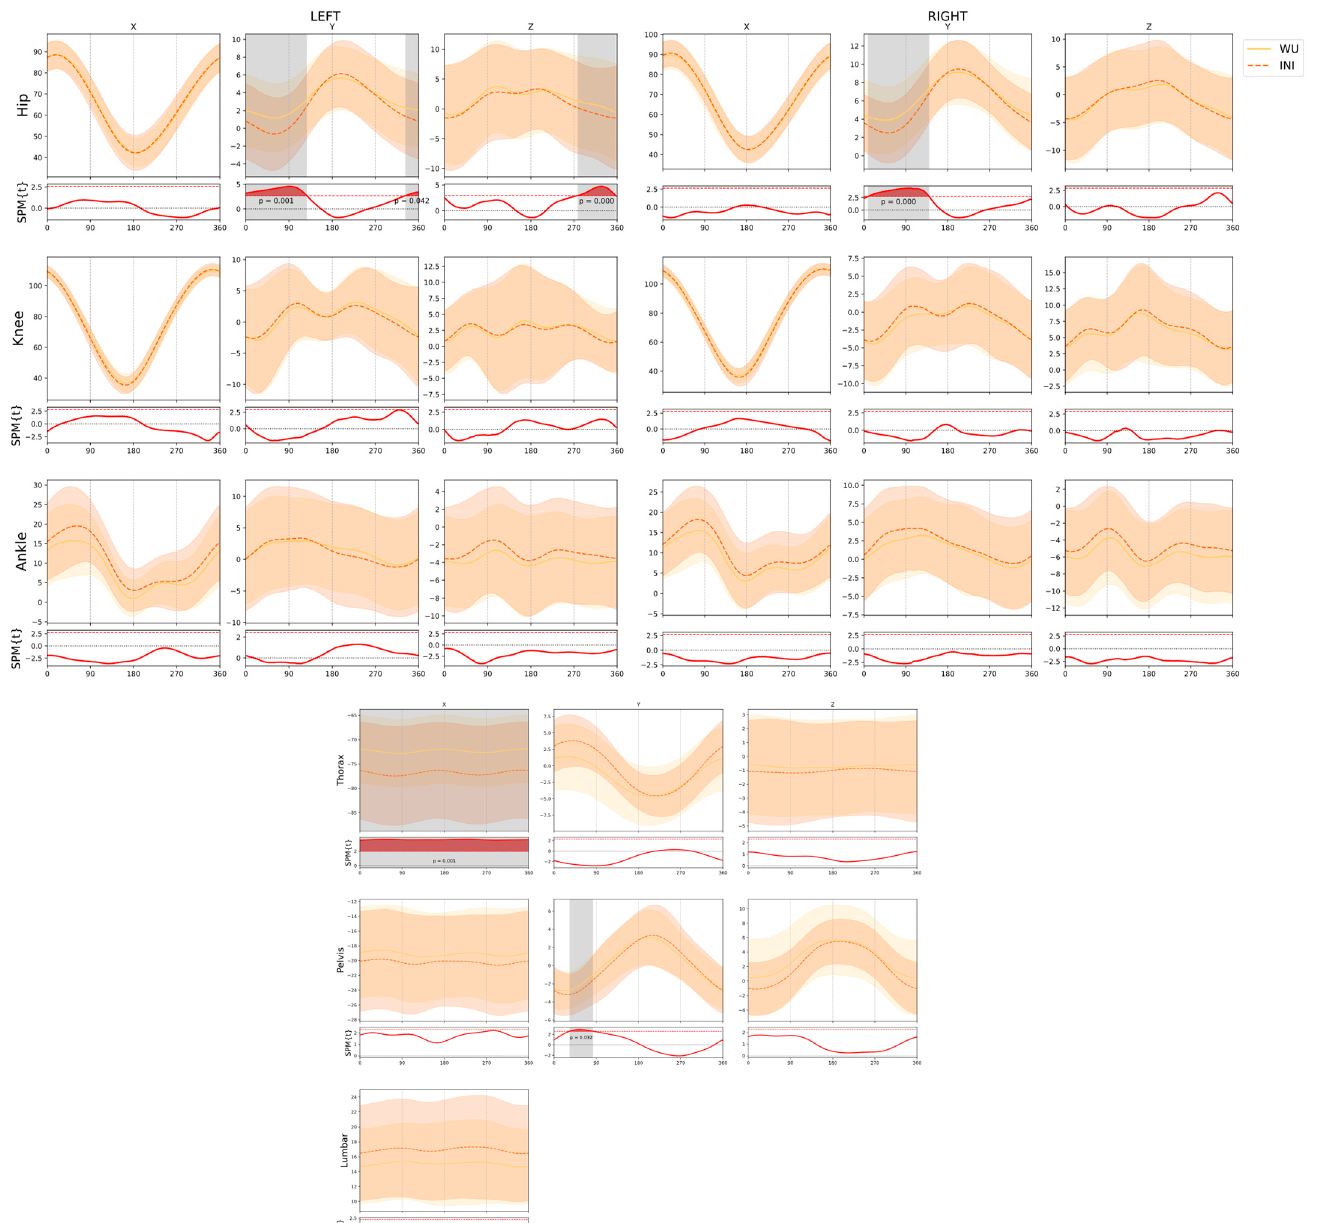
Figure 4. Comparison of the joint and segment angles between the warm-up and the initial part of the test. Lower panels display statistical parametric mapping t values from the t-test, with the dotted line representing the critical threshold. Red and grey shaded areas indicate statistical differences among conditions. Horizontal values represent one Pedaling cycle, starting from the top position of the same side pedal. WU: measurement when starting the warm-up. INI: measurement at 0 min of the test. SPM: statistical parametric mapping. x, y, z: movement in the sagittal, frontal, and transverse plane, respectively.